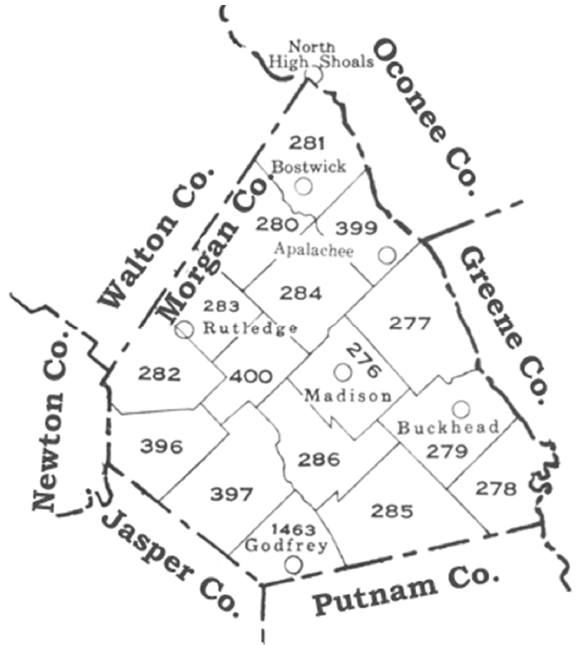
Figure 5. Morgan Co., GA, Militia Districts (Georgia USGenWeb Archives Project, http://www.usgwarchives.net/ga/maps/morgan.gif, accessed on 1 July 2022). William A. Allen and family lived in GMD 283 in northern Morgan County from about 1809 until about 1825. His brother Charles Allen remained in the area for the rest of his life.